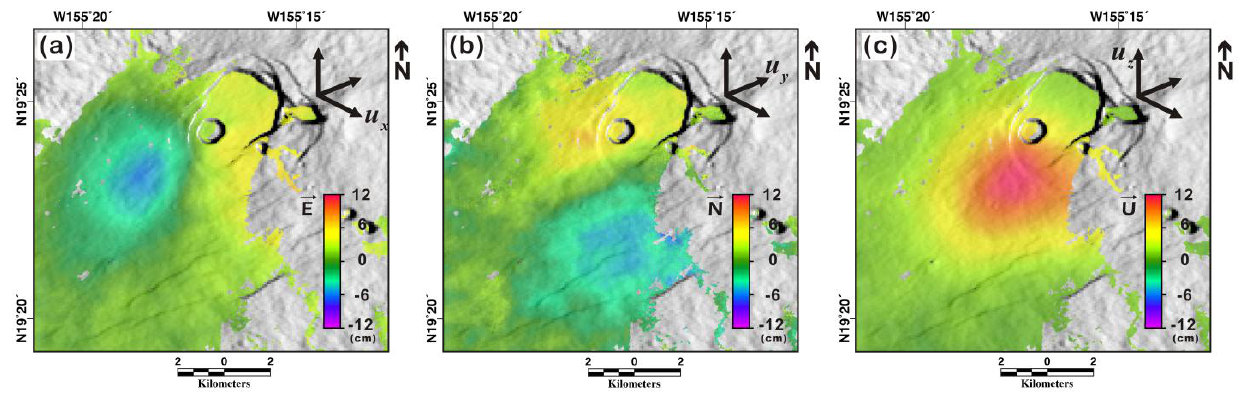
Figure 3. 3D surface displacement maps retrieved from integrating multi-stacked InSAR and MAI measurements: ( a ) east, ( b ) north, and ( c ) up components of surface deformation. Positive signals represent eastward, northward, and upward movements.